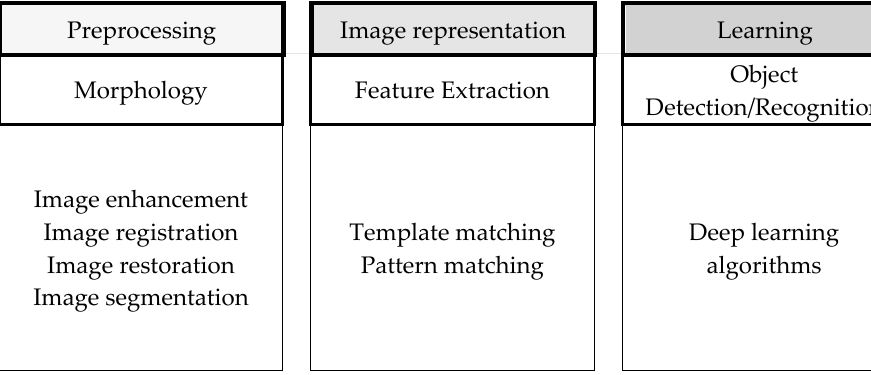
Figure 5. Computer vision techniques used in sewer defect detection automation.